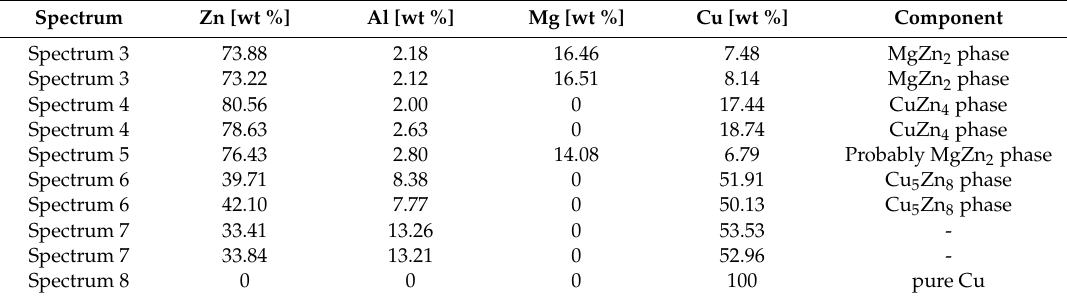
Figure 18. The EDX point analysis of the Cu/Zn5Al3Mg boundary. Table 6. The phase composition results of Cu/Zn5Al3Mg boundary.